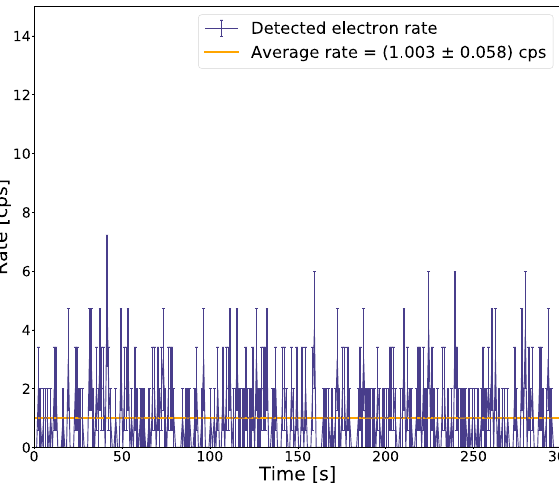
Fig. 10 Focal Plane Detector background electron rate for setting A, Table 1 and a stationary electron catcher inside the flux tube. No rate bursts were observed with this